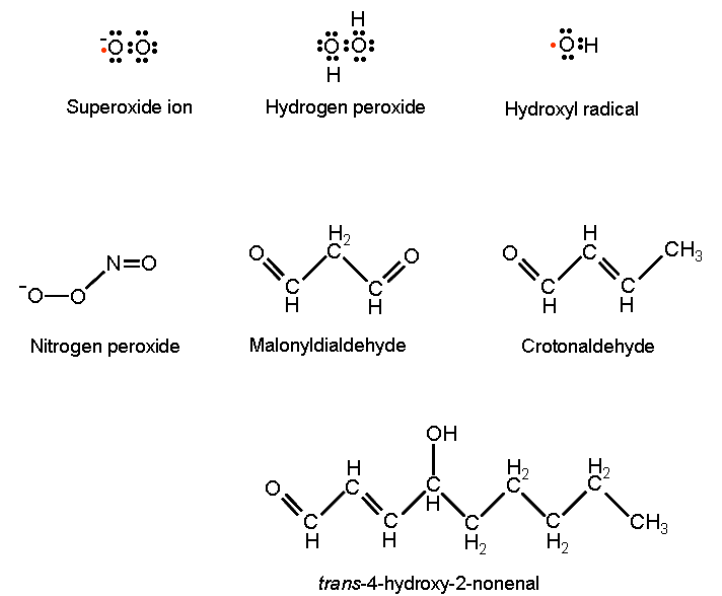
Figure 1. Lewis formulas of reactive oxygen and nitrogen species and structural formulas of lipid peroxidation products responsible for DNA modifications with miscoding